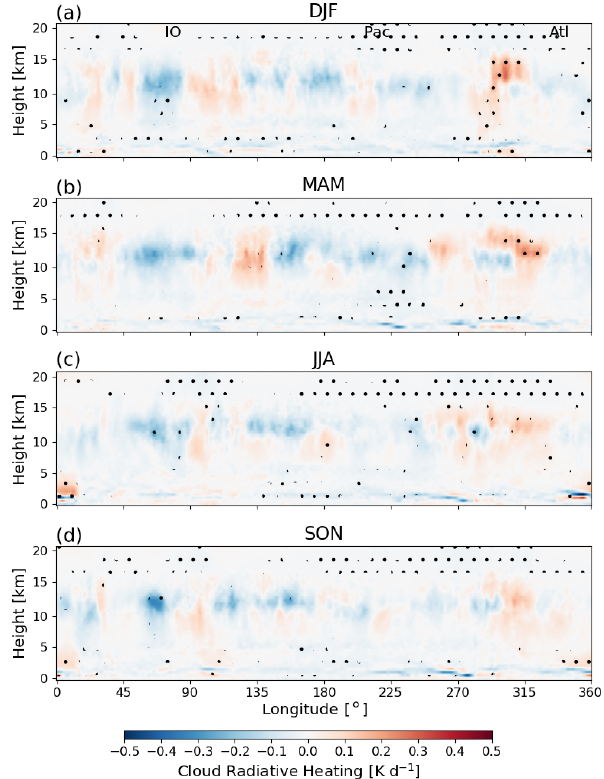
Figure 3. Cloud radiative heating difference between the PRIMAV- ERA version of EC-Earth with high and standard resolutions (EC- Earth3P-HR minus EC-Earth3P). The differences where a Student t test has a 95% confidence based on monthly mean values are marked with black dots.